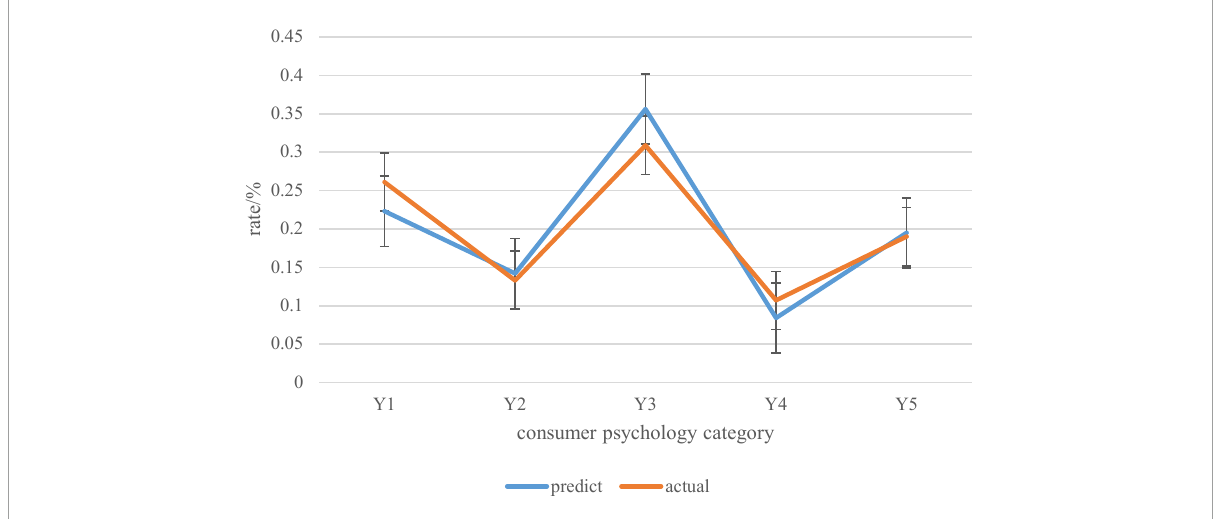
FIGURE12 Predicted probability distribution and actual probability distribution of consumer psychology categories based on Canopy clustering algorithm.